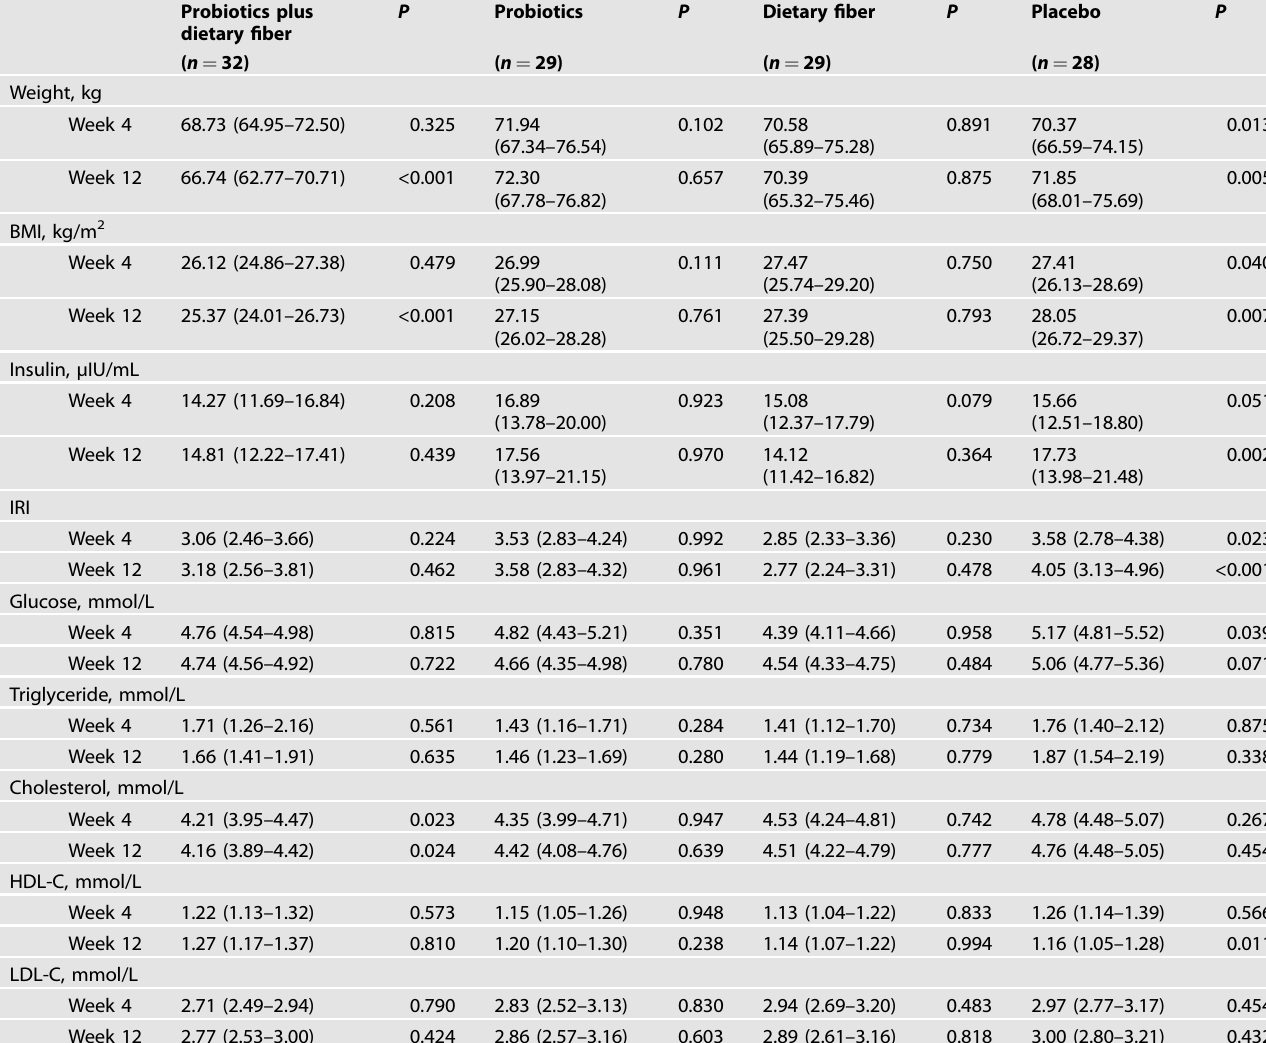
Table 2. Treatment outcomes of 118 participants across treatment groups at week 4 and week 12. Probiotics plus dietary fi